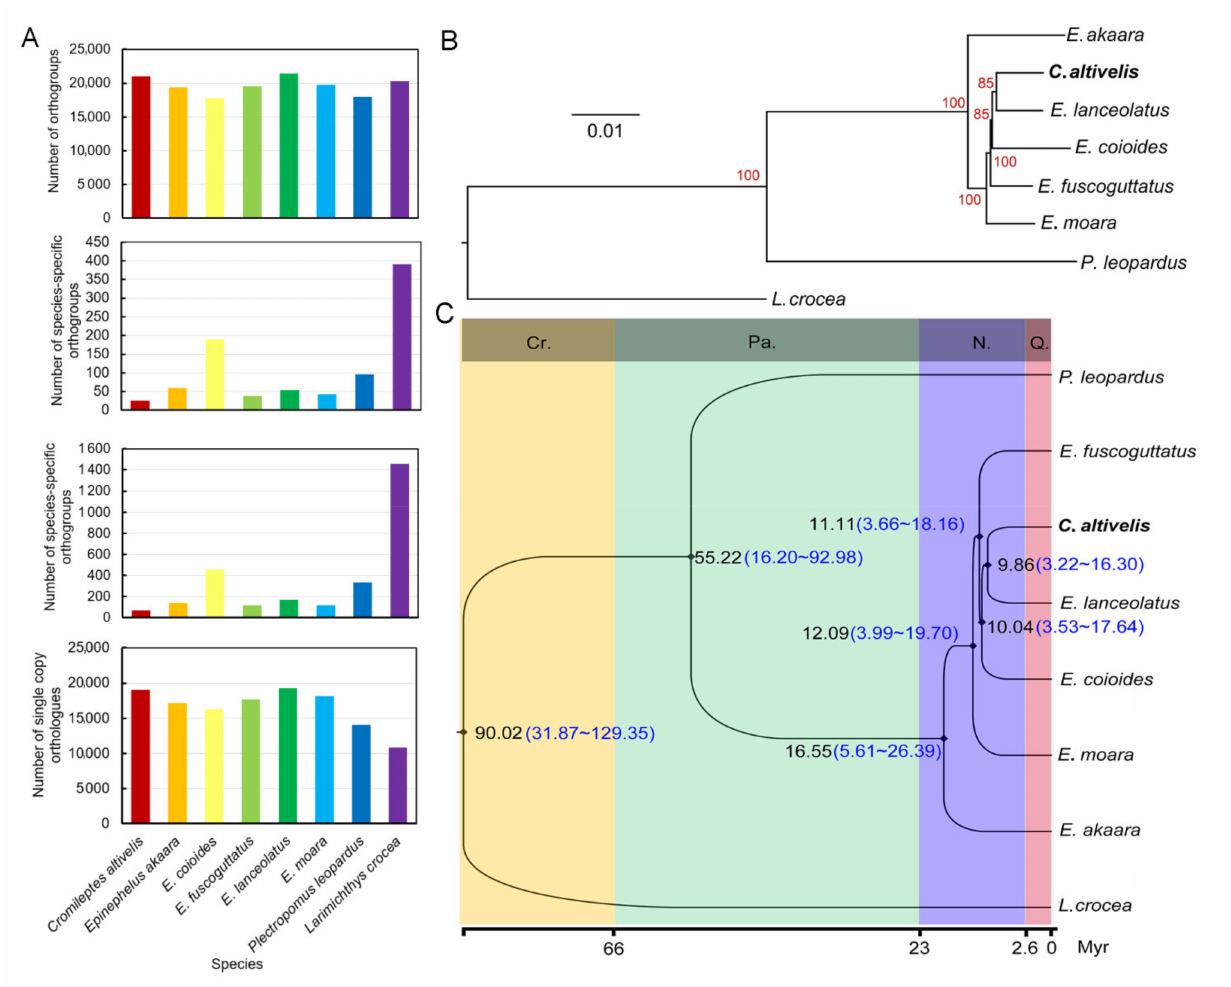
Figure 3. Analysis of divergence time of humpback grouper and other grouper species. Large yellow croaker ( L. crocea ) was set as outgroup. ( A ) The orthogroups statistics of the eight species; ( B ) phylogenetic tree of humpback grouper and other grouper species, red number indicated the bootstrap values; ( C ) Analysis of divergence time between humpback grouper and other grouper species using MCMCtree in PAML, the bold word indicated fish species used in the present study; two calibration times were obtained from TimeTree database; black number indicated the mean value of divergence time, blue number indicated the 95% confidence intervals of divergence times; Cr.—Cretaceous, Pa.—Paleogene, N.